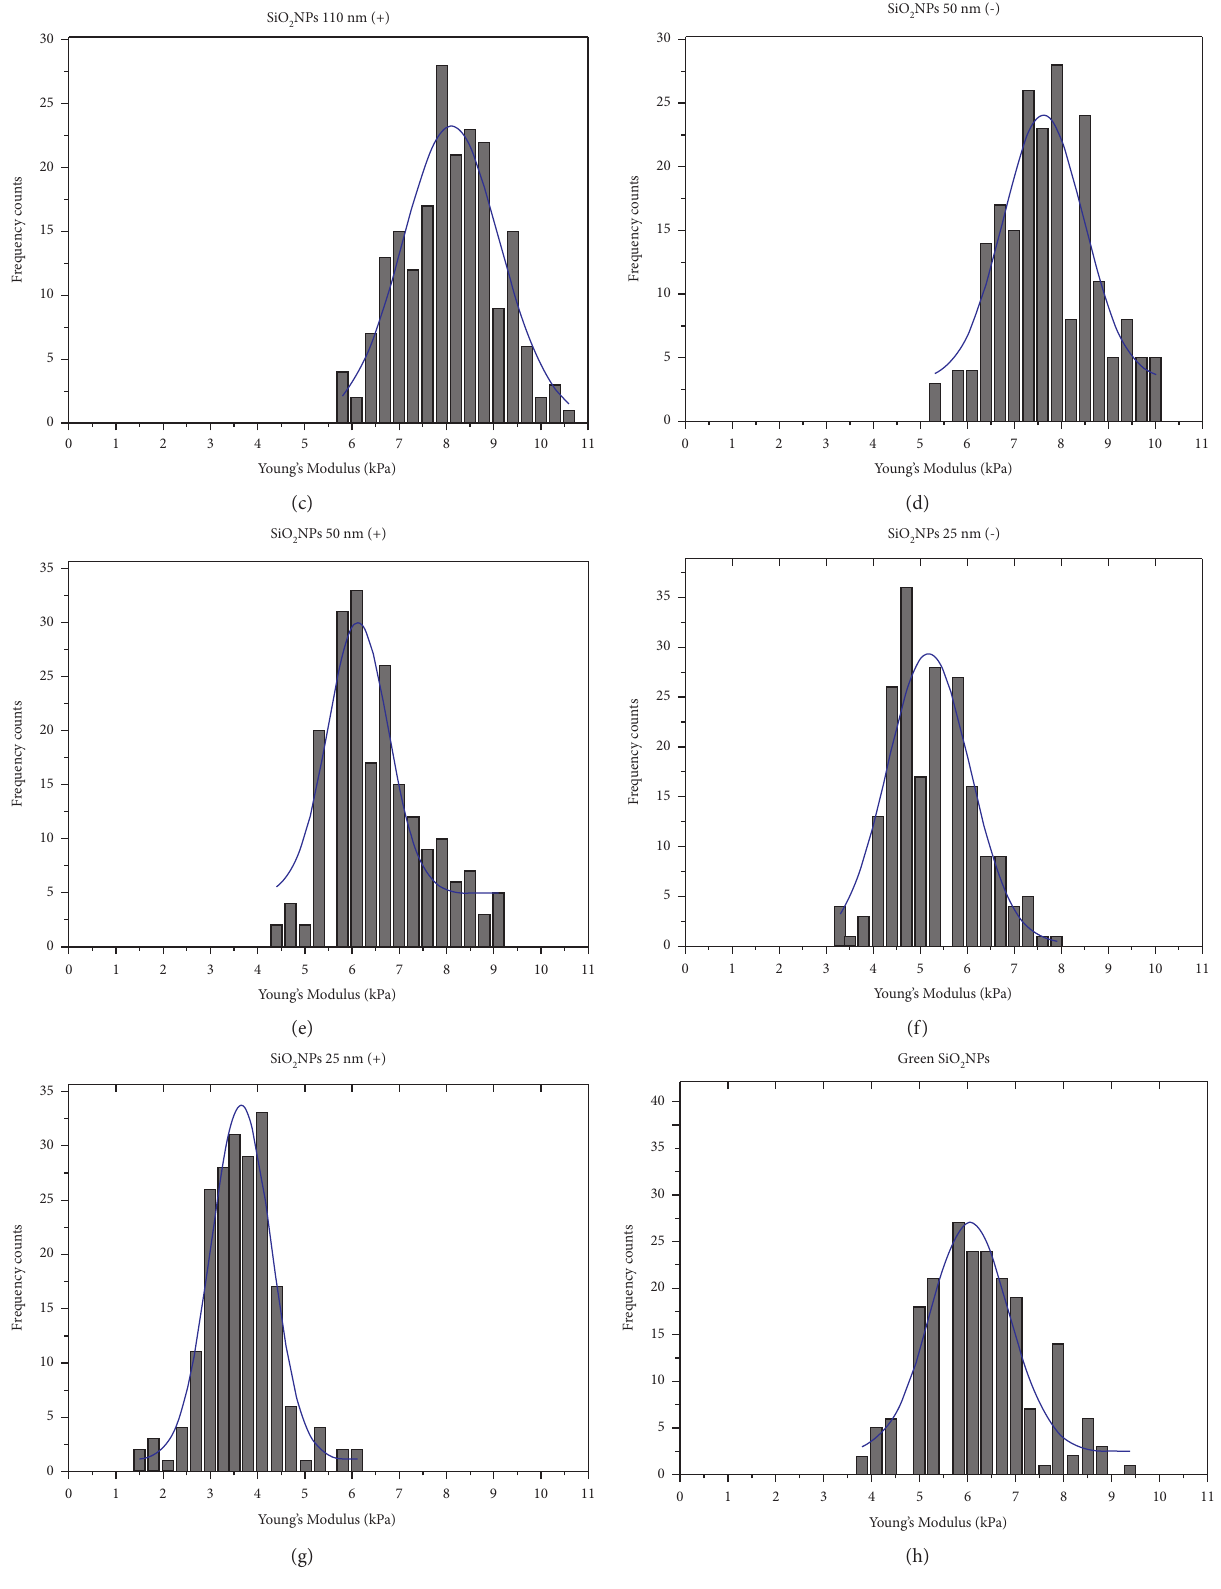
Figure 14: Young’s modulus distributions with Gaussian fit functions (blue line). Control A549 cells (a) and cells exposed to 5mg/mL of SiO 2 NPs 110 nm ( − ) (b), SiO 2 NPs 110nm (+) (c), SiO 2 NPs 50nm ( − ) (d), SiO 2 NPs 50nm (+) (e), SiO 2 NPs 25nm ( − ) (f), SiO 2 NPs 25nm (+) (g), and green SiO 2 NPs (h) for 24